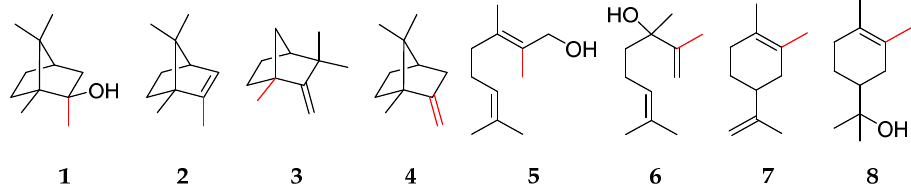
Figure 1. Structures of methylated terpenes, which have been identified in the environment with red-labeled bonds to the additional methyl group: 2-methylisoborneol 1 , 2-methyl-2-bornene 2 , 1-methylcamphene 3 , 2-methylenebornane 4 , 2-methylgeraniol 5 , 2-methyllinalool 6 , 2-methyllimonene 7 , and 2-methyl- α -terpineol 8 .